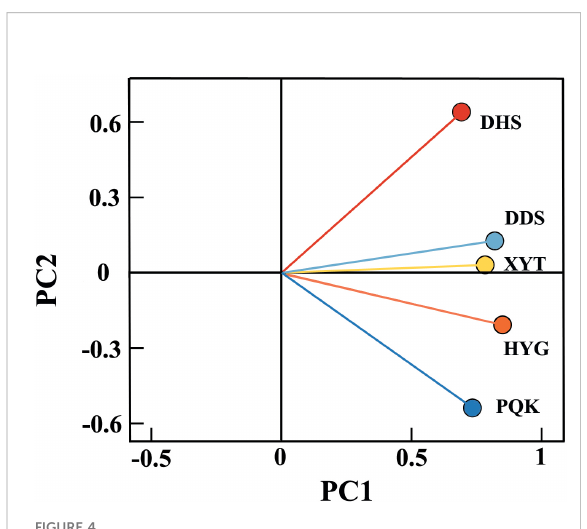
FIGURE 4 Principal component analysis of the fi ve residual chronologies.